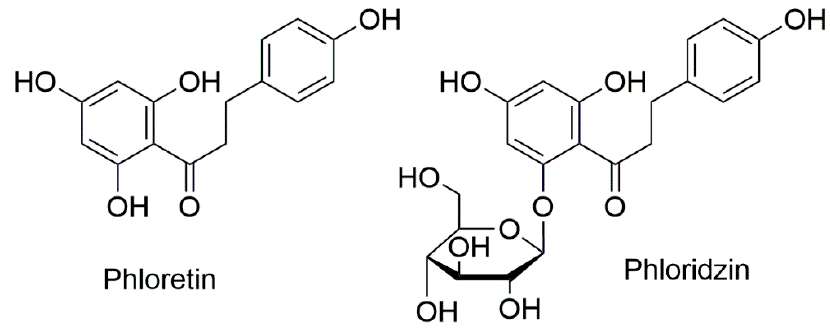
Figure 1. Chemical structures of phloretin and phloridzin (phloretin 2 ′ - O -glucose).